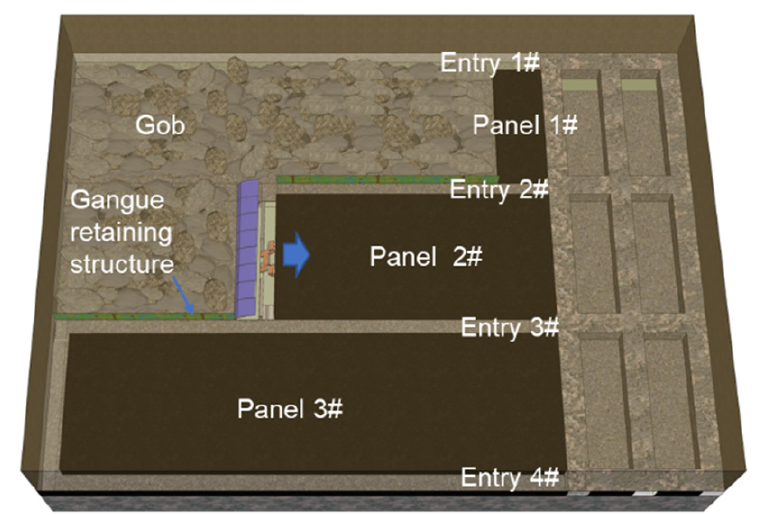
Figure 1. Layout of working faces and roadways for the GERRC.